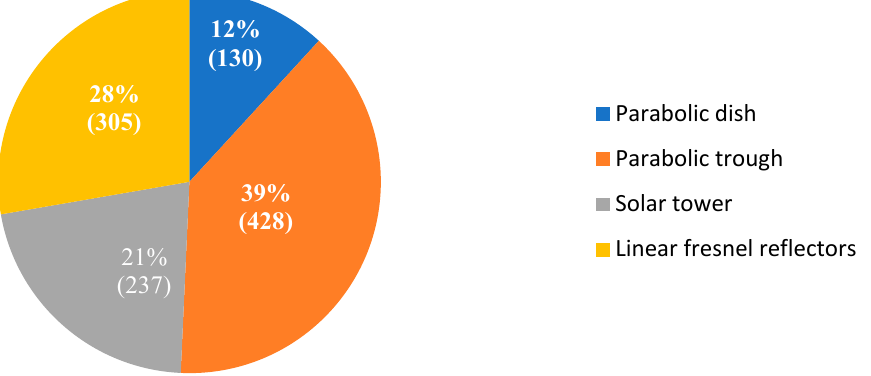
Figure 4. Distribution of di ff erent technologies in ORC application for solar energy patents.